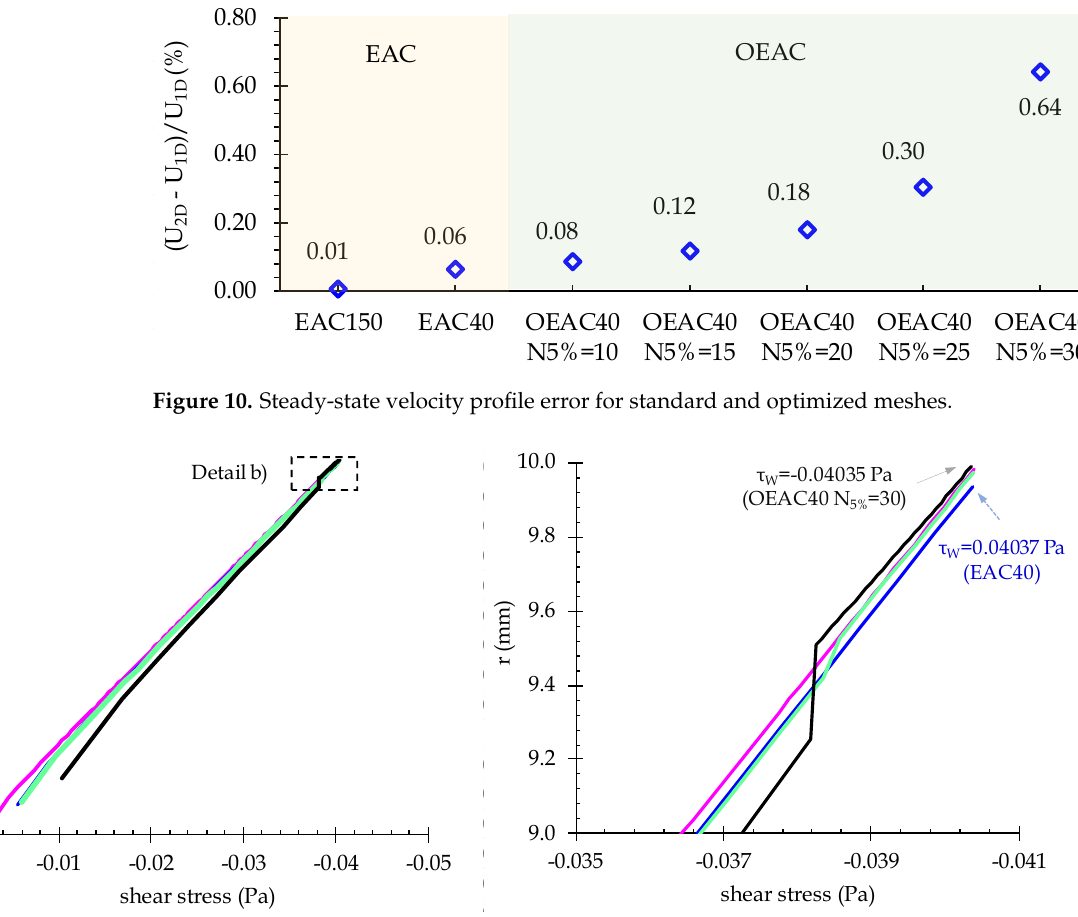
Figure 11. Shear stress profile for EAC40, EAC150, OEAC40 N5% = 10 and OEAC40 N5% = 30: ( a ) 0 ≤ r ≤ 10 mm; and ( b ) 9.0 ≤ r ≤ 10 mm.